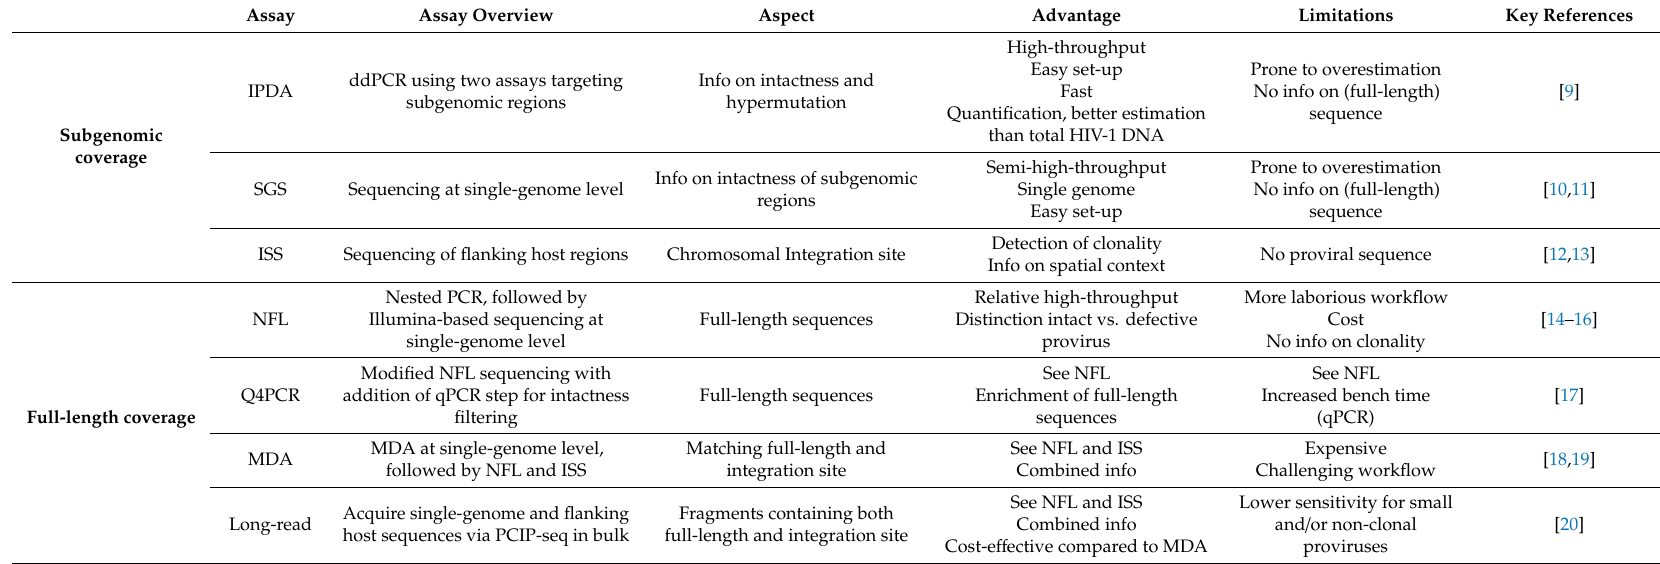
Table 1. A selection of PCR-based assays. IPDA = intact proviral DNA assay, SGS = single-genome / proviral sequencing, ISS = integration site sequencing, Q4PCR = quadruplex qPCR, NFL = near full-length sequencing, MDA = multiple-displacement amplification-based technologies, long-read = pooled CRISPR inverse PCR